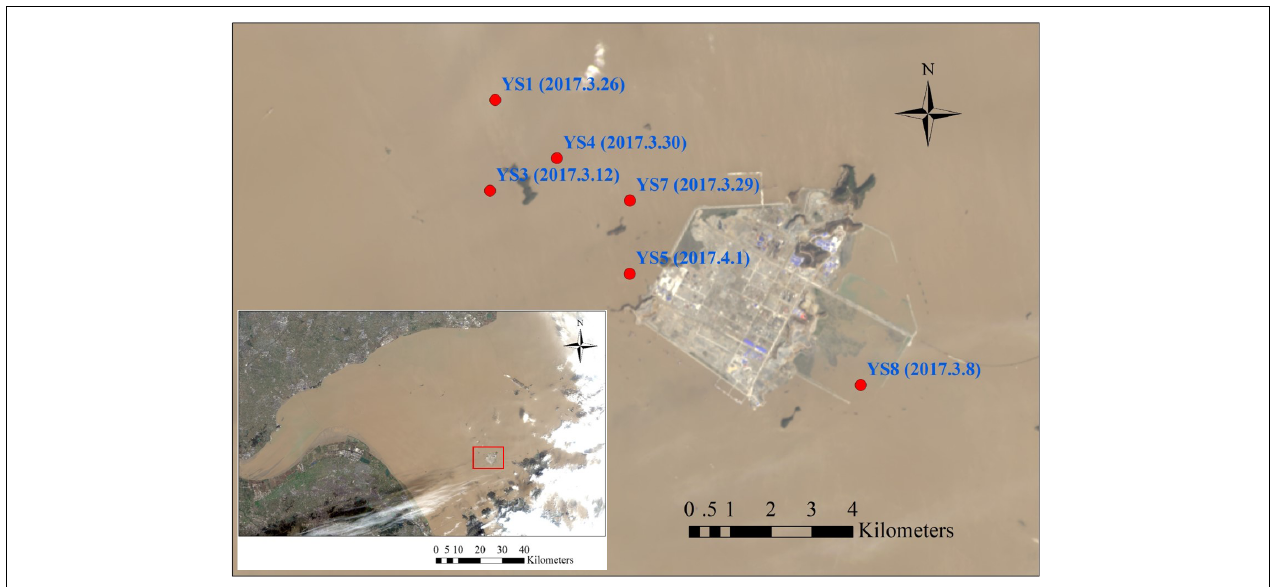
FIGURE 1 | The location of sampling